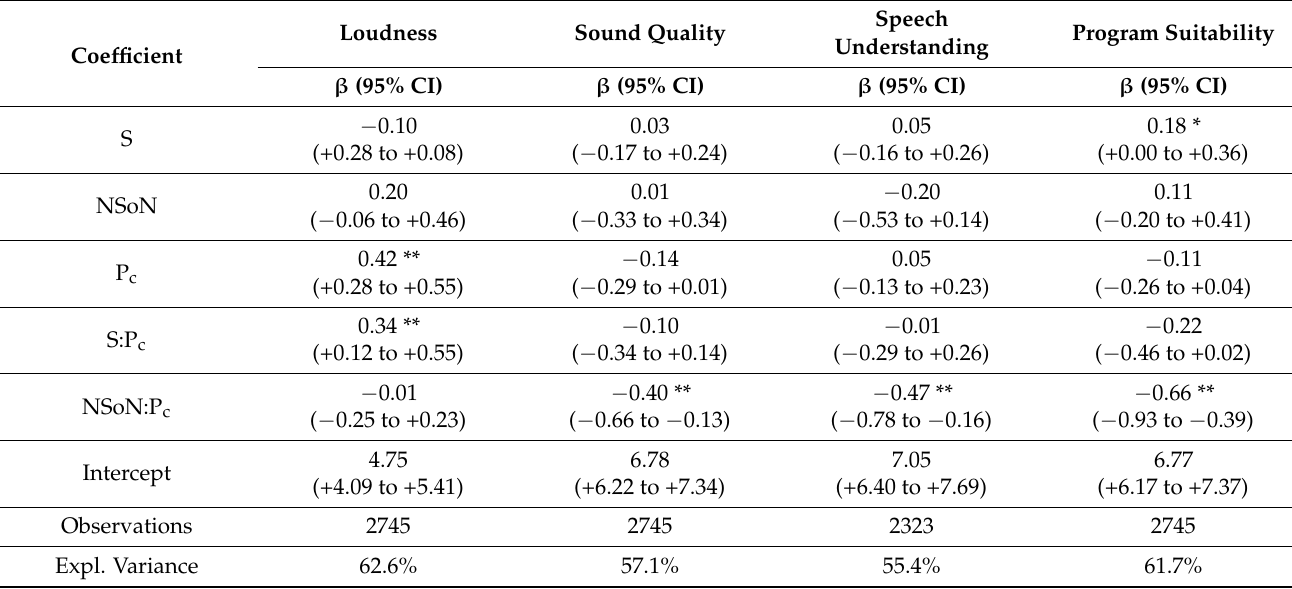
Table 4. Regression coefficients ( β ) with 95% CIs from LME models predicting EMA ratings. Baseline contrasts were Quiet soundscape and the default listening